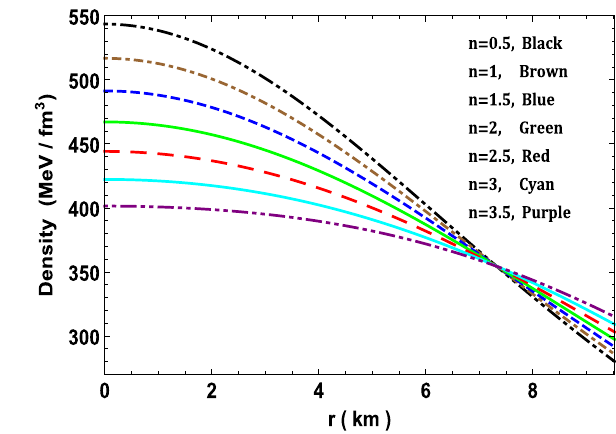
Fig. 2 Variation of density with radial coordinate r for 4U 1608-52 ( M = 1 . 74 M (cid:9) , R = 9 . 528 km) by taking a = 0 . 001 km − 2 and β = 0 . 01